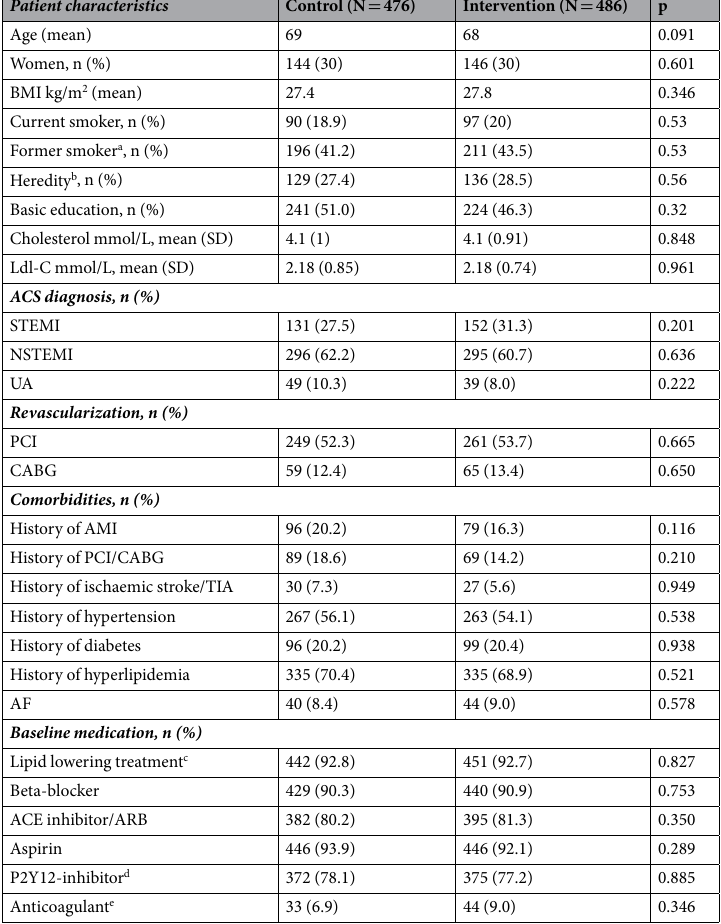
Table 1. Baseline characteristics. a Former smoker: smoking cessation > 6 months; b Heredity: first-degree relative with cardiovascular disease, male < 55, female < 65; c Statin or ezetimibe; d P2Y12 inhibitors: clopidogrel, ticagrelor, prasugrel; e Anticoagulant: warfarin, non-vitamin K oral anticoagulant. BMI – Body mass index; STEMI – ST elevation myocardial infarction; NSTEMI – Non-ST elevation myocardial infarction; UA – Unstable angina; PCI – Percutaneous coronary intervention; CABG – Coronary artery bypass graft; AMI – Acute myocardial infarction; TIA – Transitory ischaemic